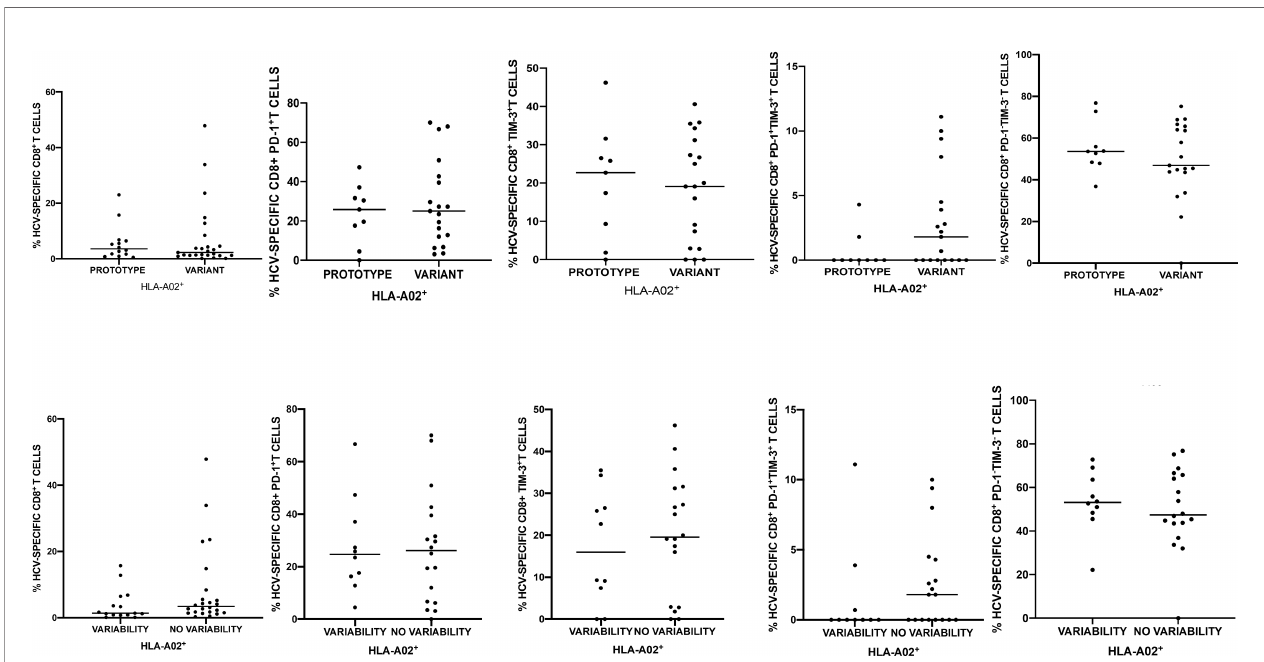
FIGURE 4 | Percentages of peripheral blood HCV-speci fi c CD8 + T-cells expressing PD-1 and Tim-3 in 40 HLA-A*02-positive patients harboring NS3 1406 prototype (GenBank EU255962.1) or variant epitope sequence as the dominant strain (upper panel). Lower panel shows intrahost aminoacid variability of this epitope where no variability denotes the presence of a single variant and variability indicates ≥ 2 variant sequences. Horizontal lines represent median